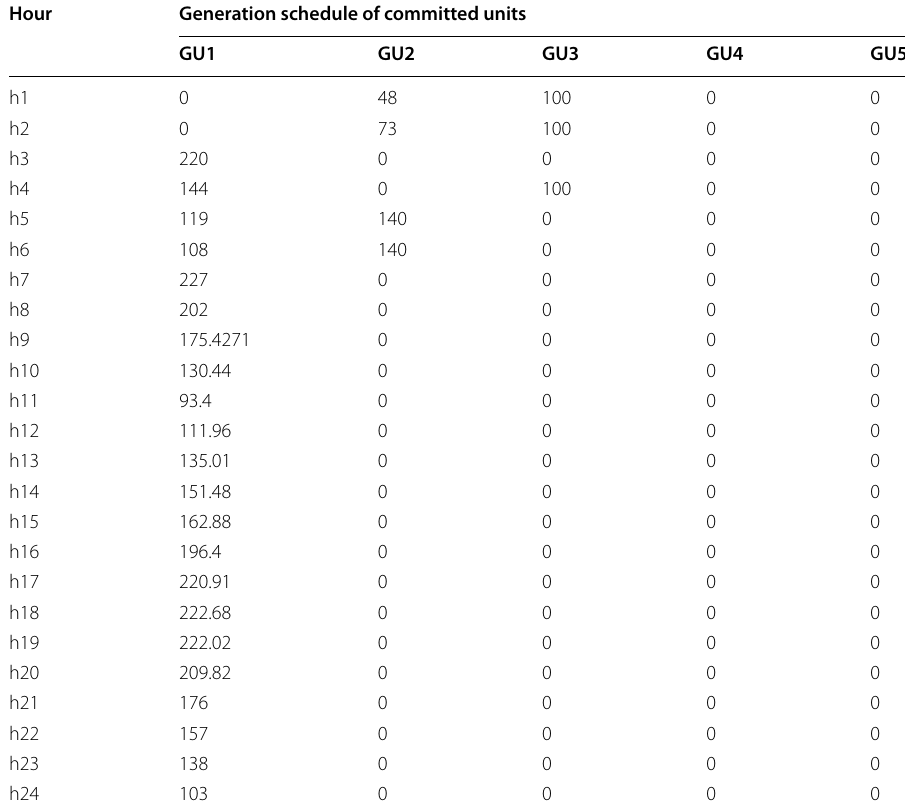
Table 12 Power scheduling for 5-generating unit system considering renewable energy in winter Hour Generation schedule of committed